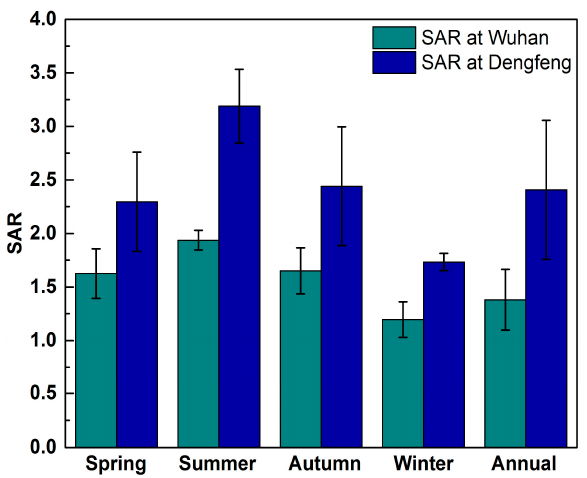
Figure 16. Annual and seasonal average SAR in Wuhan and Dengfeng.